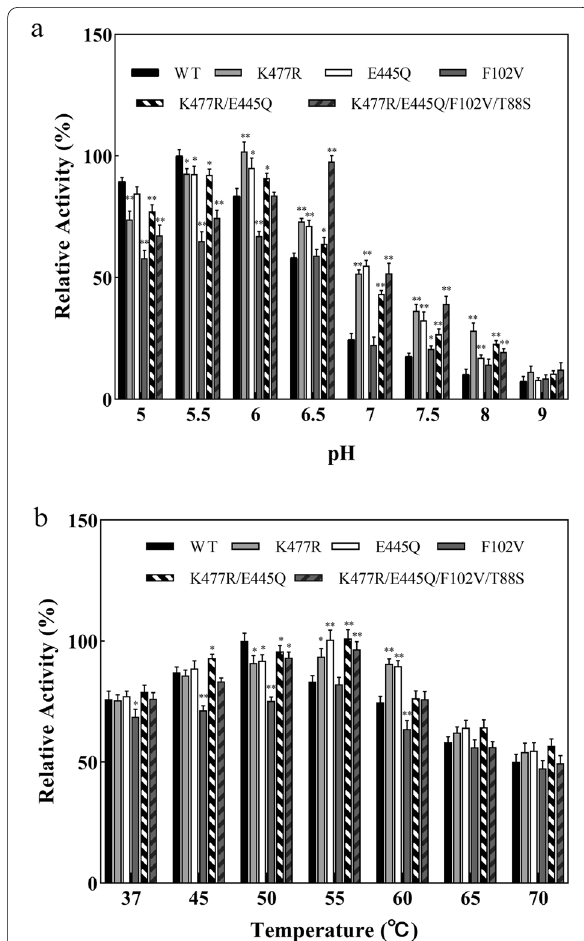
Fig. 4 Effect of pH and temperature on the activities of CadA and its mutants. a Relative activities of wild-type CadA and its mutants at different pH. All the relative activities were calculated based on the activity of the wild-type CadA at pH 5.5. b Relative activities of wild-type CadA and its mutants at different temperatures. All the relative activities were calculated based on the activity of the wild-type CadA at 50 ºC. The error bars represent standard deviations calculated from triplicate experiments, and statistical significance of the different relative cadaverine yield in comparison with the wild type was evaluated using Student’s t test (*, P < 0.05, **, P <